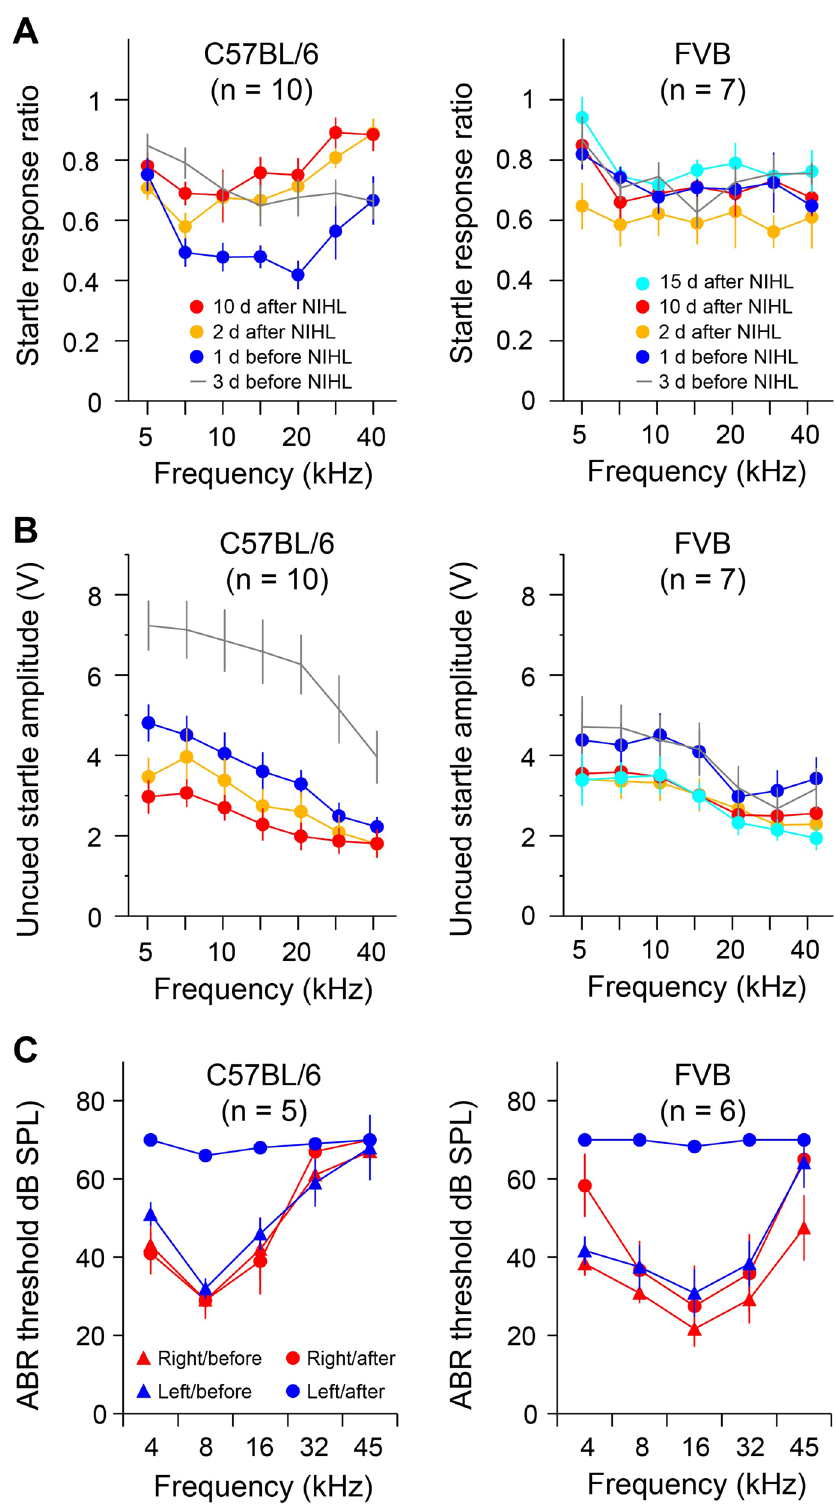
Figure 1. Strain differences in noise-induced impairment in gap detection. ( A ) Noise exposure resulted in impaired gap detection in C57BL/6 mice in a broad frequency range 2 and 10 days after the exposure. The same noise exposure did not significantly alter gap detection performances in FVB mice 2, 10 and 15 days after the exposure. ( B ) Noise exposure led to a significant reduction in startle response amplitude in C57BL/6 but not FVB mice. ( C ) Noise exposure produced similar levels of ABR threshold increases in C57BL/6 and FVB